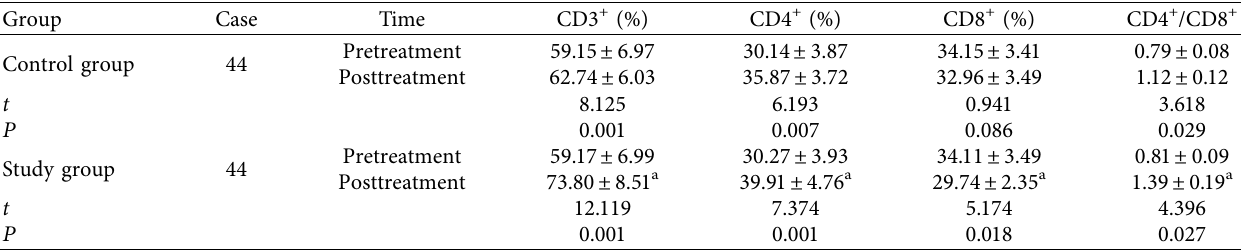
Figure 1: The levels of sICAM-1, sVCAM-1, IL-10, and IL-35 measured by ELISA of serum samples in AML patients following intravenous administration of cytarabine supplemented with either idarubicin or daunorubicin. Table 2: The proportions of CD4 + , CD8 + , and CD4 + /CD8 + ratio in peripheral blood in AML patients following intravenous administration of cytarabine supplemented with either idarubicin or